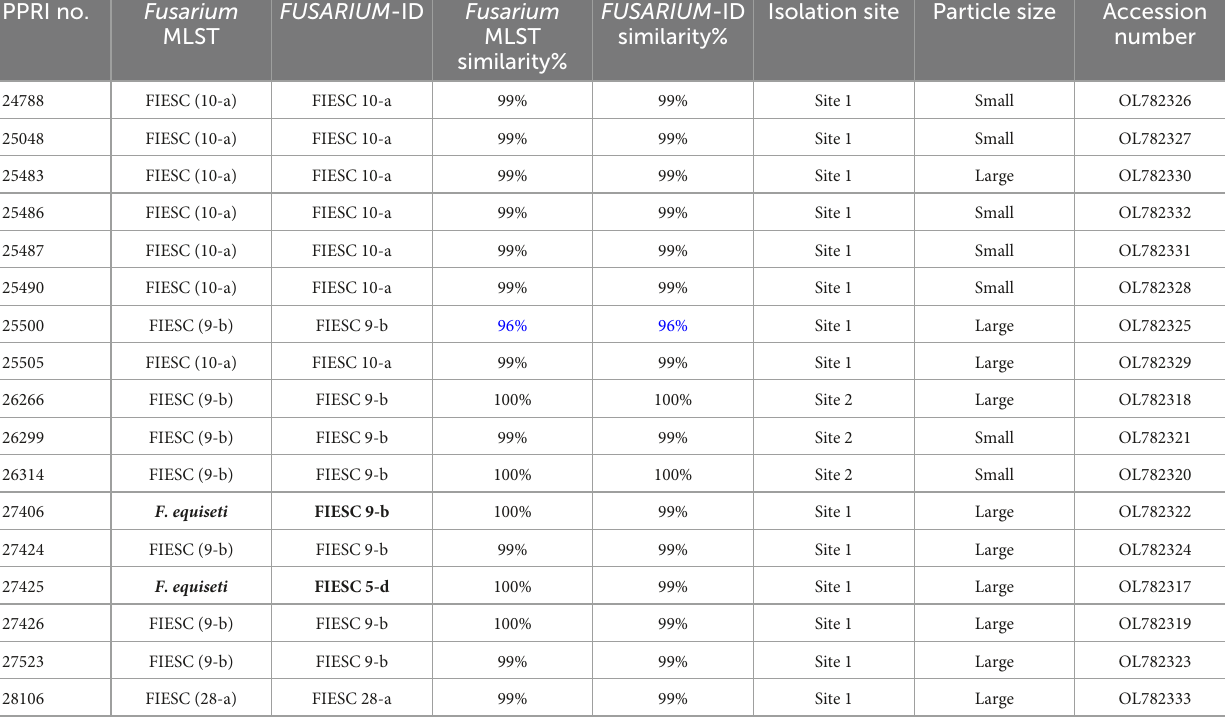
TABLE 4 Nucleotide BLAST (nBLAST TM ) results from the Fusarium MLST and FUSARIUM -ID databases for the FIESC. PPRI no.